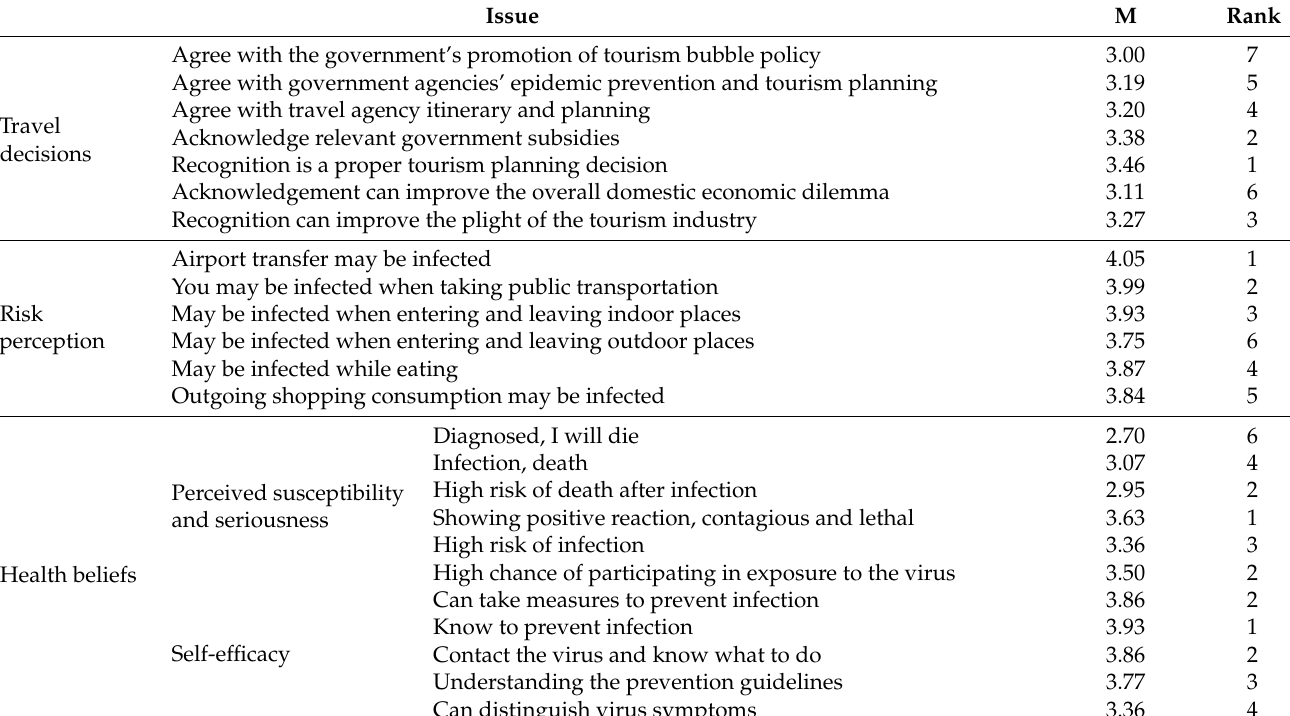
Table 3. Analysis of travel decisions, risk perception, health beliefs, physical and mental health, and travel intentions. Analysis of